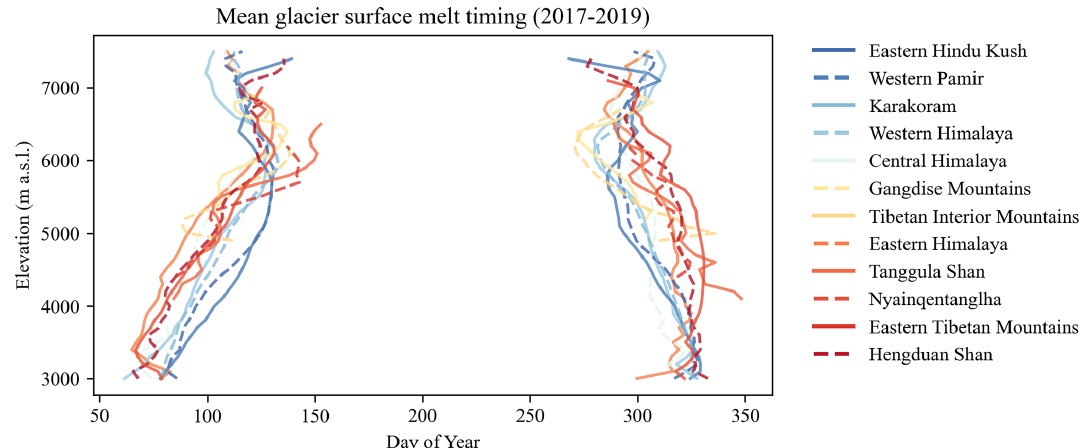
Figure 6. Mean melt onset (MO; left) and freeze onset (FO; right) summarized in 100m elevation bins using the 30m SRTM digital elevation model (Farr, 2007) and 12 HiMAP sub-regions (Shean, 2020). The blue-to-red color scale indicates the longitude of the HiMAP region centroid, where the westernmost regions are shown in dark blue and easternmost shown in dark red.